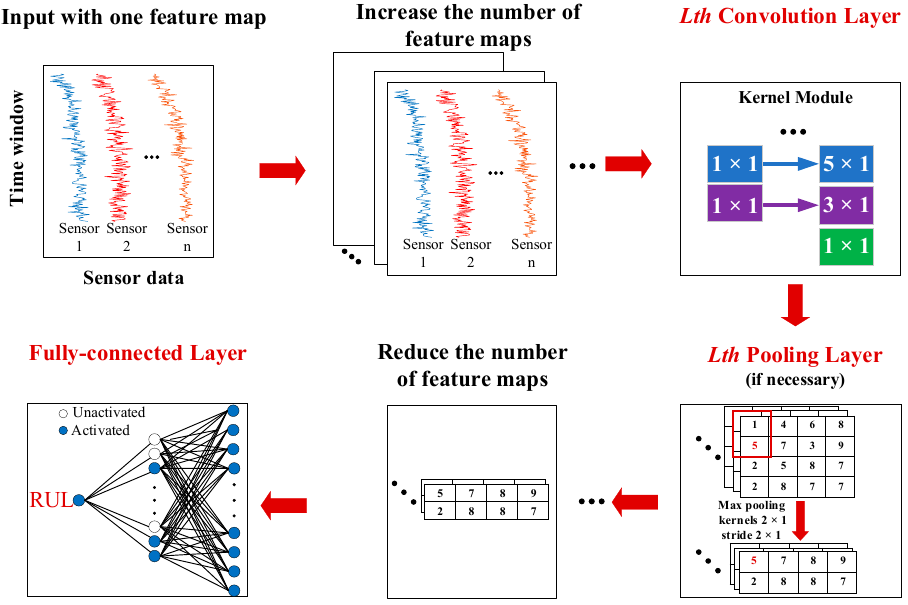
Figure 2. The flowchart of the proposed architecture.